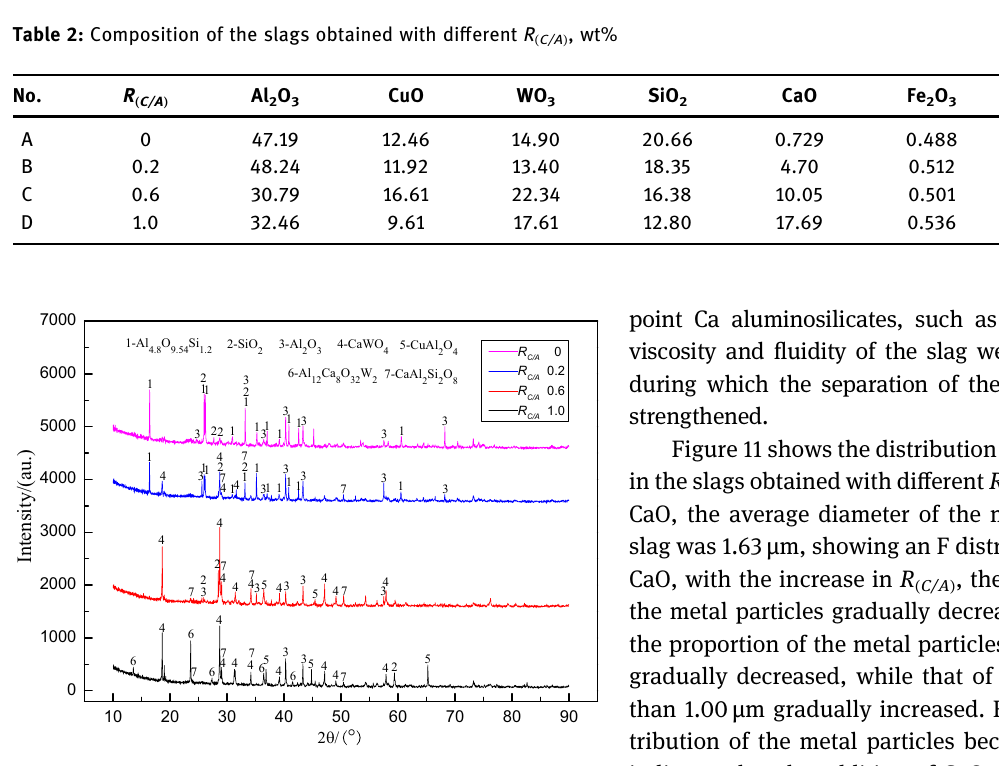
Figure 9: XRD patterns of the slags obtained with di ff erent R ( C/A ) .